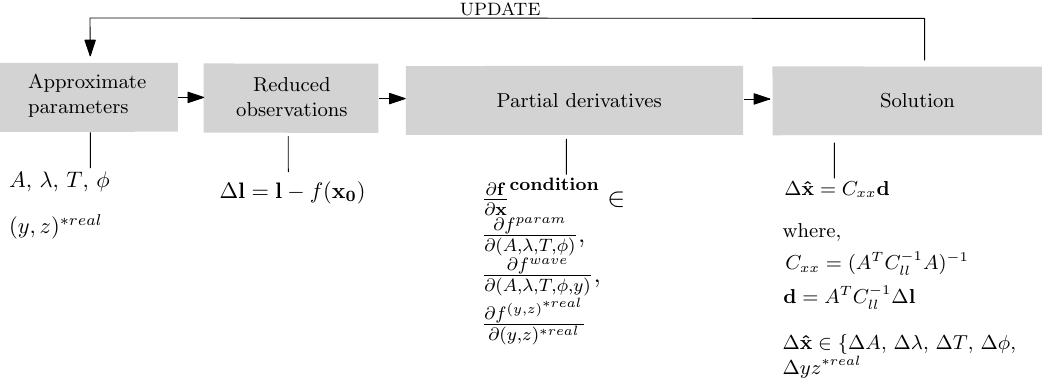
Figure 3. The least squares adjustment workflow of Method 1. The cycle repeats until the stop criterion is reached. ∂ x denotes the entire vector of parameters; A is the Jacobian in observation equations; and C ll is the covariance matrix. See f wave , f param in Equations (2) and